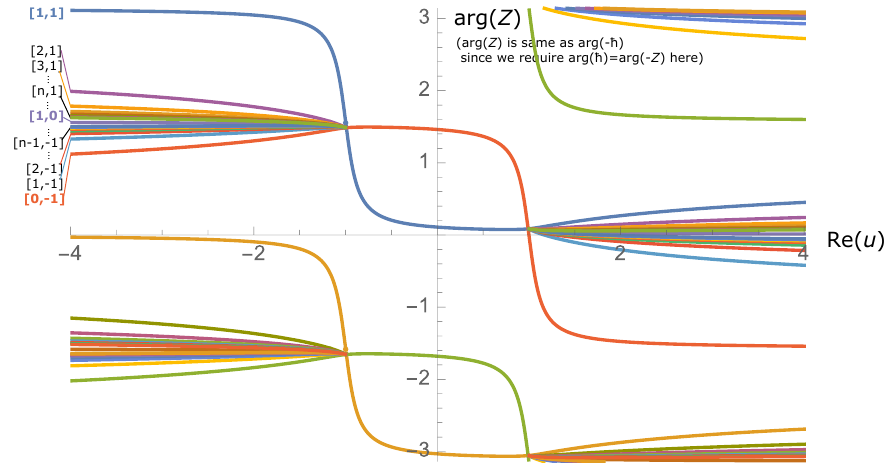
. The horizontal axis is Re( u ) . Figure 14 . The BPS walls when we fix Λ = 1 and Im( u ) = i 10 There are two special points around at u 1 + i and u 1 + i where the wall of marginal 1 ≈ − 2 ≈ 10 10 stability is encountered: arg( Z ) = arg( Z ) . For Re( u ) ∈ ( u ) (strong coupling) we γ [1 , 1] γ [0 , − 1] 1 , u 2 have 2 hypermultiplets and their antiparticles, so there are 4 walls in total shown in this region. For Re( u ) < Re( u ) or Re( u ) > Re( u ) (weak coupling), we have infinitely many 1 2